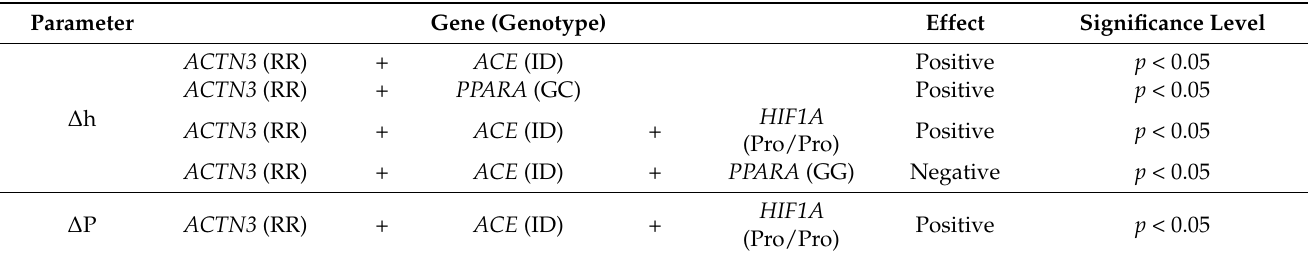
Table 6. Combined effect of ACTN3 , ACE , PPARA and HIF1A gene genotypes on selected parameters of the supercompensation effect at CJ10 in the experimental